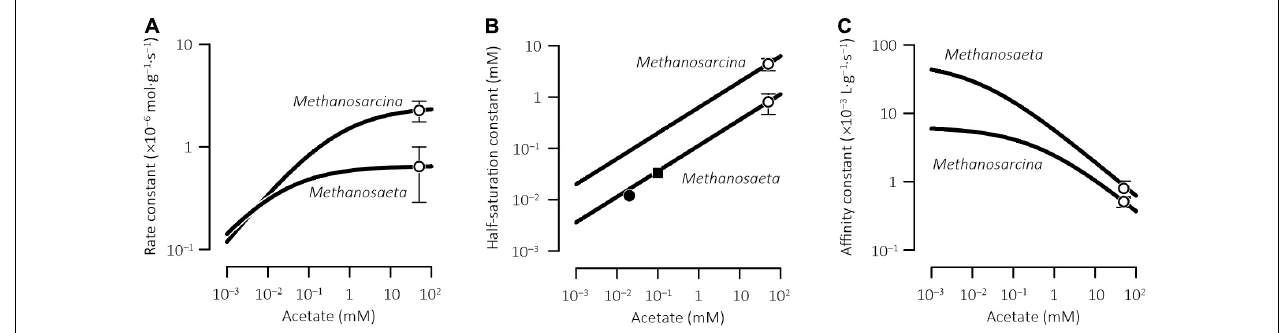
FIGURE 3 | Acclimation model extrapolates the kinetic parameters of methanogenesis determined for laboratory cultures to the environment of different acetate concentrations. Open symbols are the values determined experimentally for pure cultures and error bars show standard deviations (see Table 1 ); closed symbols are those determined in the sediments from a lake ( (cid:4) , Lovley and Klug, 1983) and a wetland ( (cid:108) , Roden and Wetzel, 2002); solid lines are rate constants (A) , half-saturation constants (B) , and affinity constants (C) calculated according to Eqs